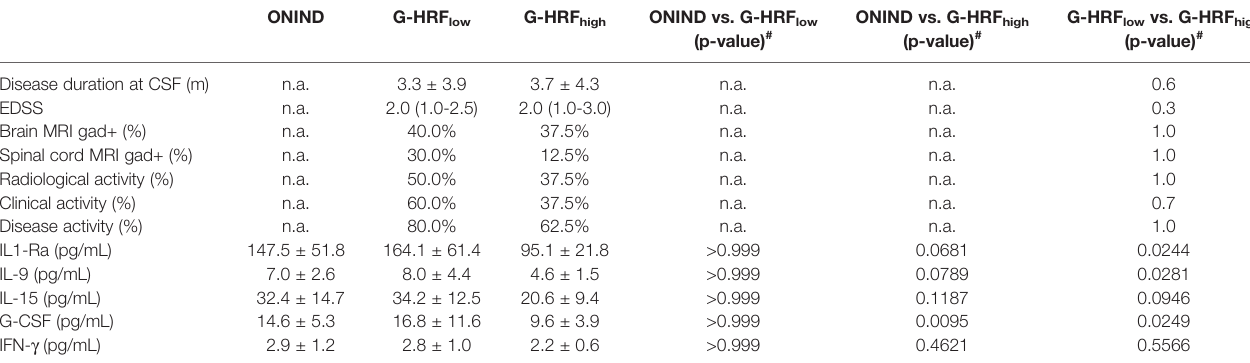
TABLE 2 | CSF concentrations of cytokines correlating with GCL HRF count.